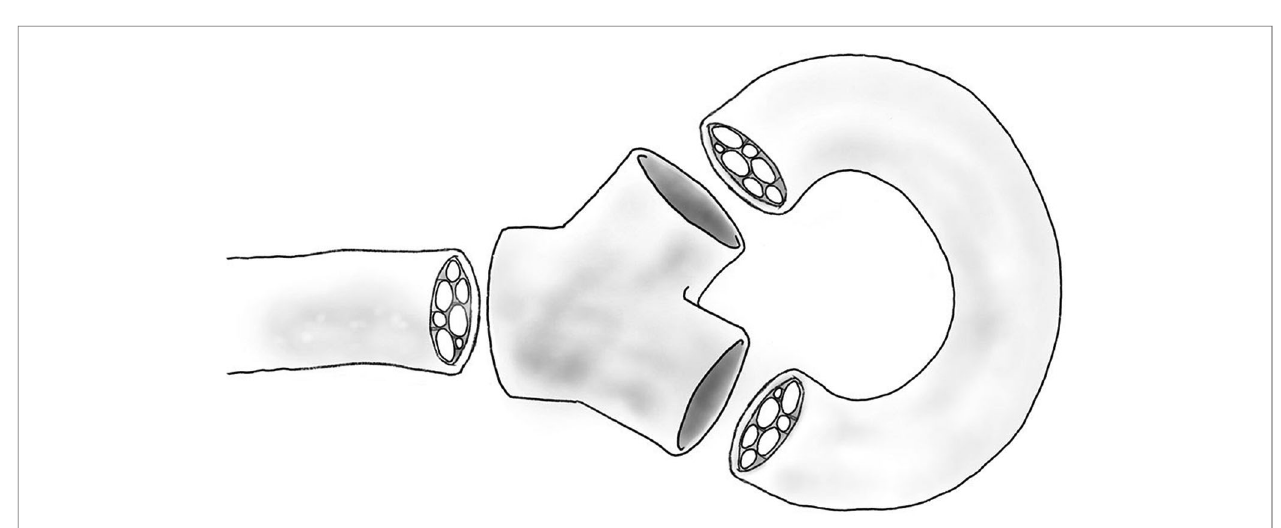
FIGURE 3 | Diagram of open-ended Y-tube with